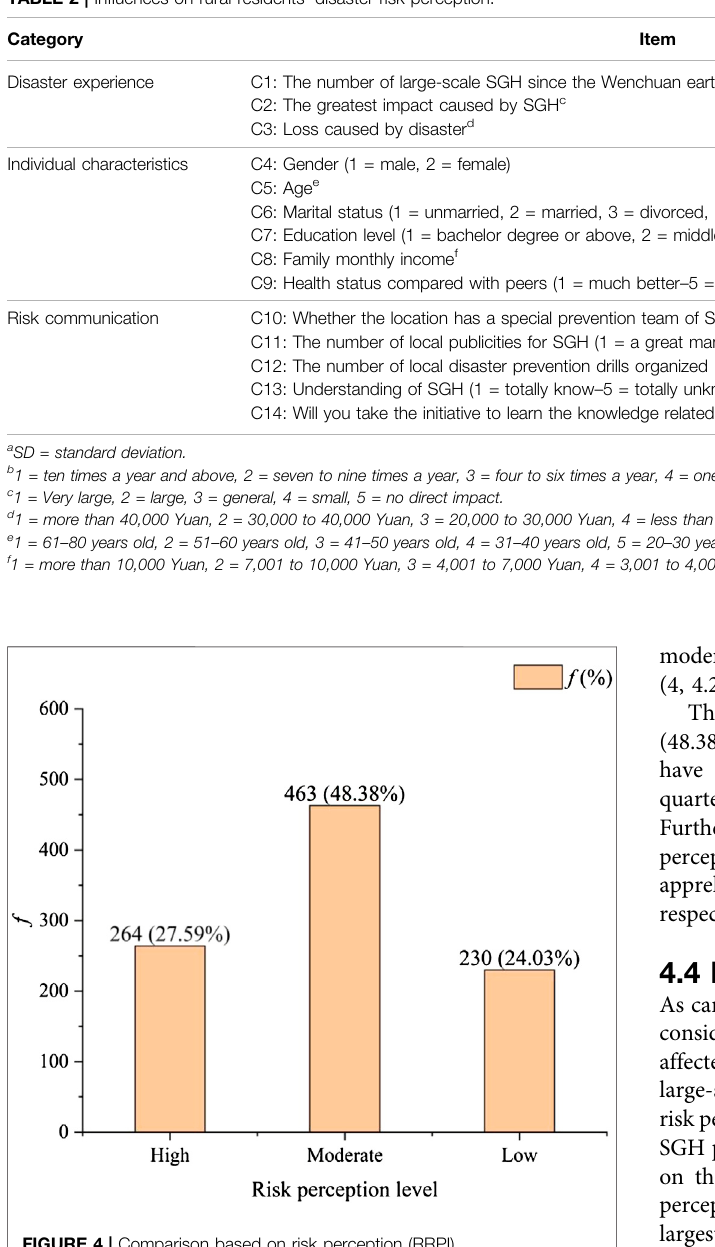
FIGURE 4 | Comparison based on risk perception